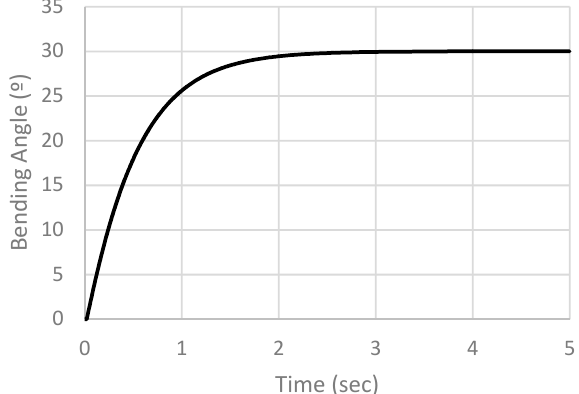
Figure 23. Simulation results of PID controller with Kp = 0.5, Ki = 0.05 and Kd = 0.001. This response is noticeably slow. So, the controller’s parameters were tuned, and the new controller’s parameters were selected to be Kp = 1.5 and Ki = 0.5. The derivative action was removed, so we expect to see an overshoot. The job was resubmitted, and results were extracted, to be displayed in Figure 24. From the actuator response we notice that the rise time is now equal to 0.00647 s, the settling time (ts) (5%) = 0.094318 s and ts (2%) = 0.194318 s, with an overshoot of 0.20973 degrees, as expected. The root mean square (RMS) error is calculated and is equal to 0.322116338 degrees, corresponding to 1.07372%. Such a perfor- mance is better than the previous one in terms of characteristics and RMS error. So, PI controller is selected.